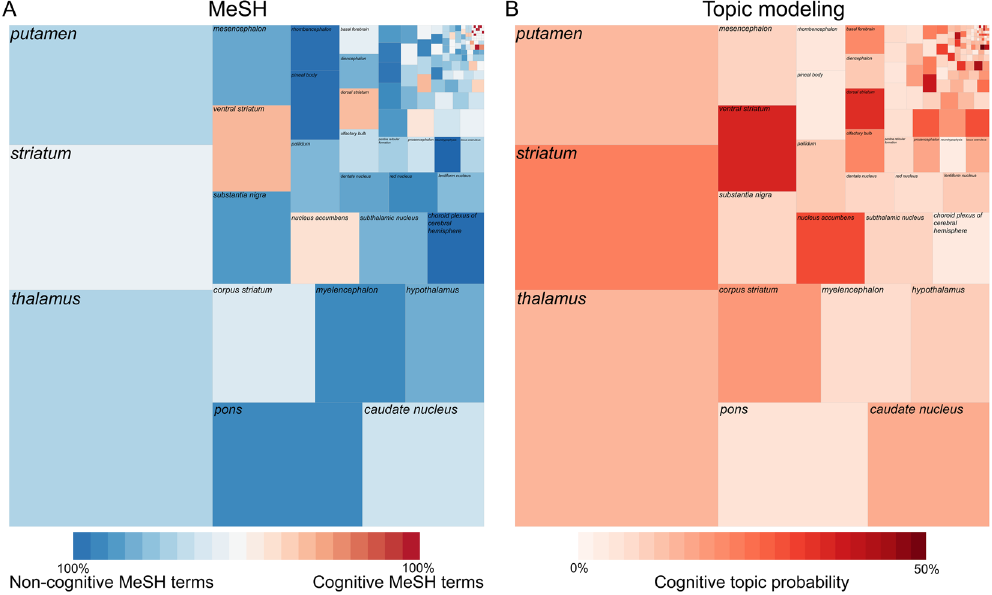
Figure 1. A few structures account for most of the retrieved publications, but usage of cognitive versus non- cognitive topics do not depend on the ontology. The area associated with each of those 145 structures is based on the number of unique publications found with this query. ( A ) The color coding reflects the proportion of publications that contained MesH topics associated with cognitive terms for each structure. ( B ) The color coding reflects the proportion of publications that contained data-driven topics associated with cognitive terms for each